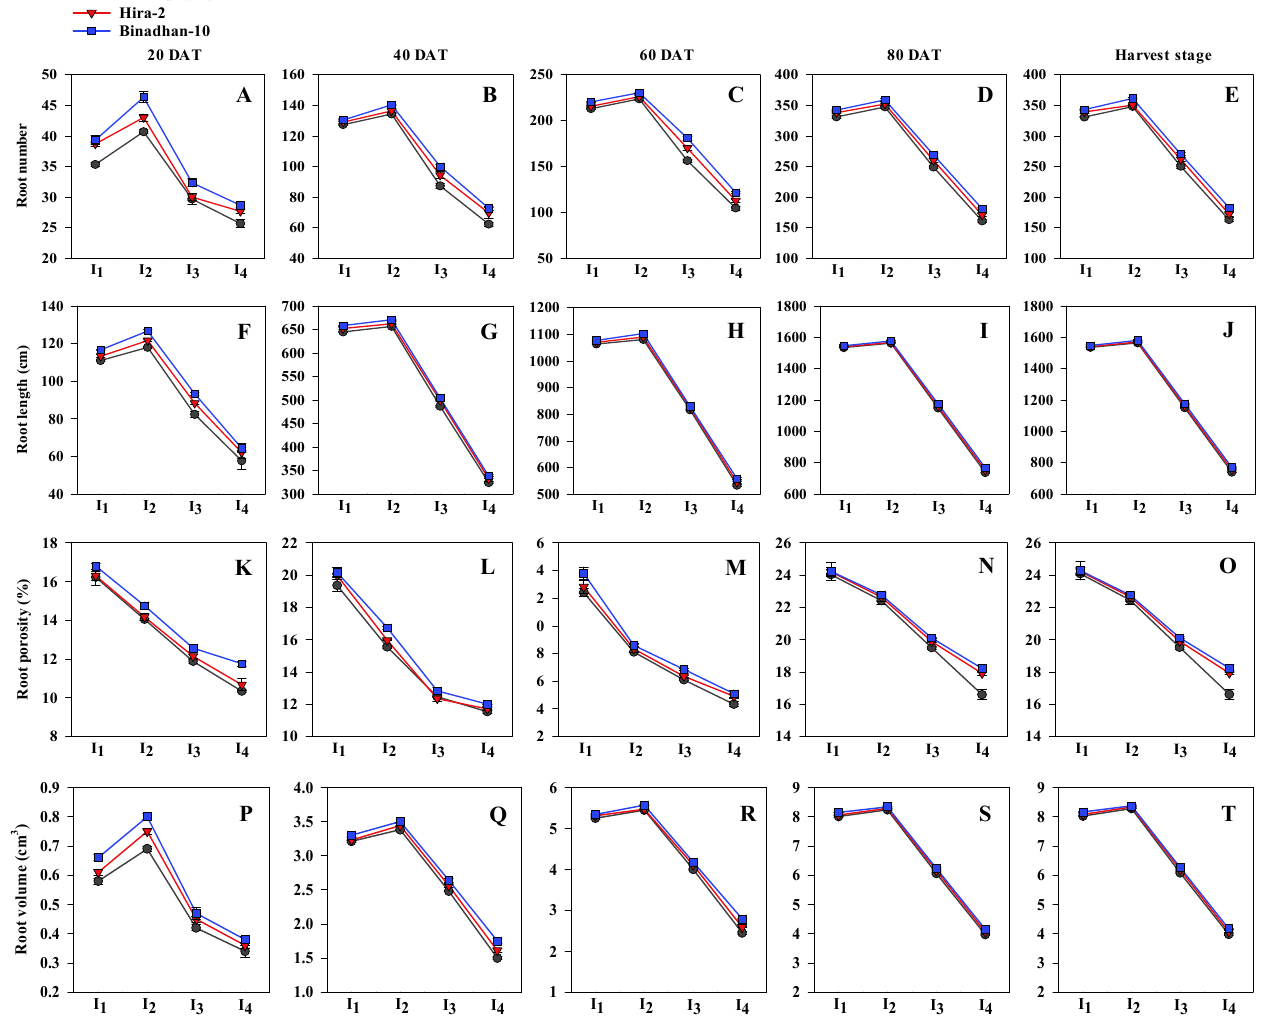
Figure 1. Variable root morphological attributes of three rice cultivars at four irrigation regimes during 20 DAT to harvest stage. I 1 -Continuous flooding, I 2 -Saturation, I 3 -75% of saturation, I 4 :50% of saturation; ( A – E ) represent root number; ( F – J ) represent root length; ( K – O ) represent root porosity; ( P – T ) represent root volume.